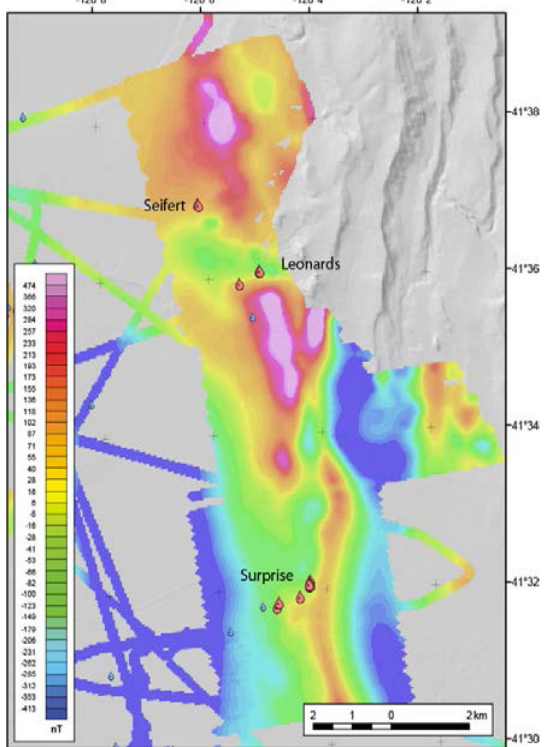
Figure 6: Magnetic residual map of a portion of the SIERRA flight data showing the location of cold (blue symbols) and hot (red symbols) springs (from J. M. G. Glen,